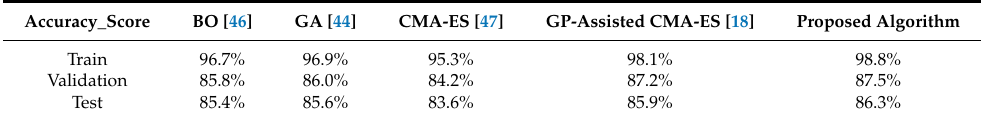
Table 6. Simulated results of all experimental algorithms with 2000 spiking neurons on